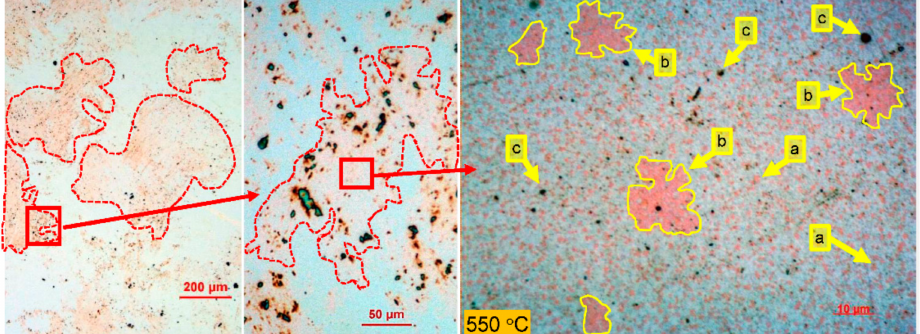
Figure 6. Optical micrograph of the CuIC micro-Si thin film with (glass / p-type Si / Cu) structure after annealing at 550 ◦ C.